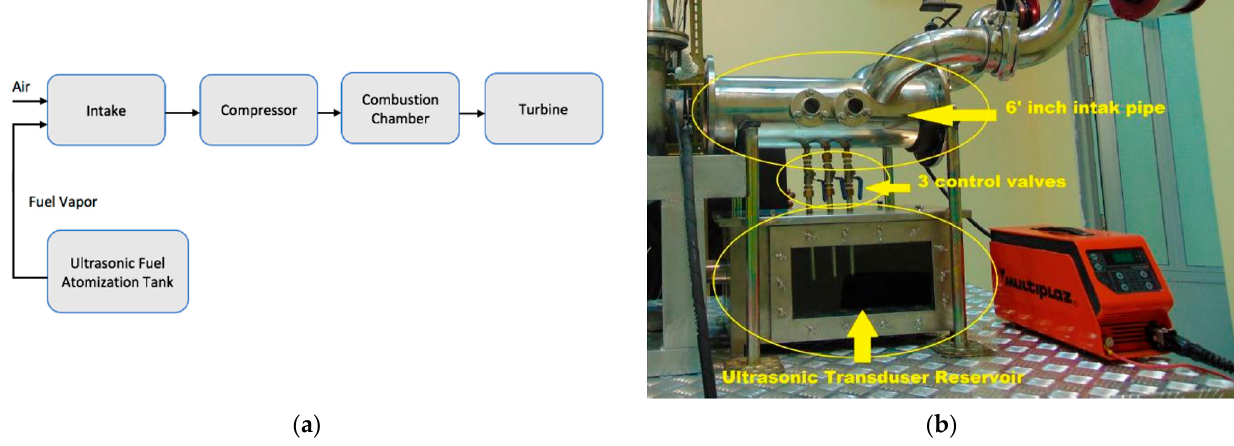
Figure 3. ( a ) Block diagram for ultrasonic atomization technique and ( b ) ultrasonic tank constructed with the system. Table 1. Specification and values of ultrasonic device.